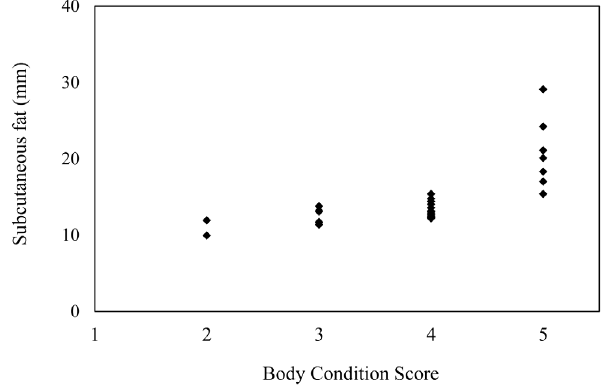
Figure 5. Scatter plot of body condition scores and overall mean ultrasound measurements of fat thickness for all five body regions combined in female African elephants.